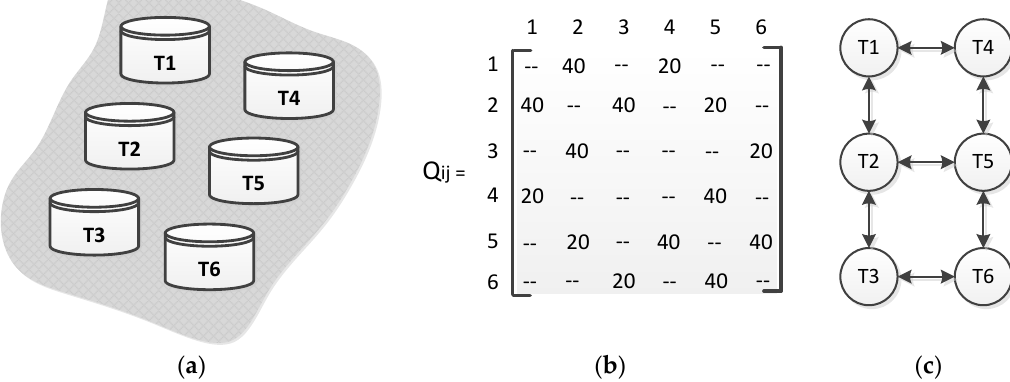
Figure 1. ( a ) Schematic of a gasoline storage terminal. ( b ) Mutual heat radiation intensities (kW/m 2 ) in the event of tank fires. ( c ) Potential fire spread paths in the terminal as a directed graph.